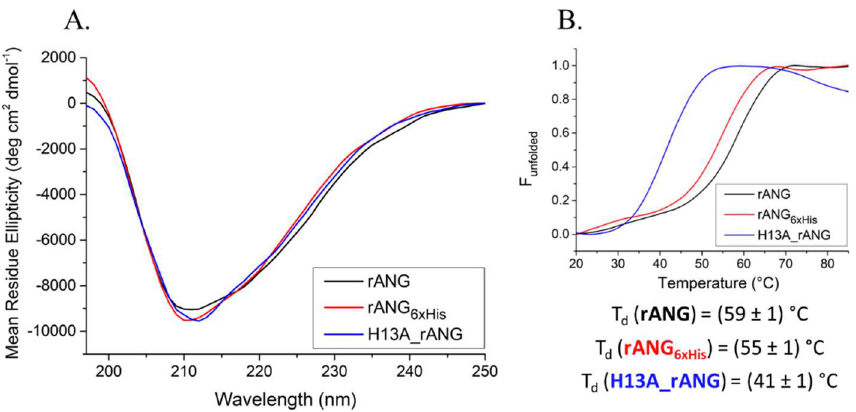
Figure 3. CD analysis of rANG and its variants. ( A ) CD spectra recorded at 20 °C in 20 mM of MES/NaOH pH 6.0 and 100 mM NaCl, using a protein concentration of 0.1 mg mL −1 ; ( B ) thermal denaturation profiles, as followed by monitoring changes in the molar ellipticity at 220 nm as a function of temperature. The denaturation temperature (T d ) for each protein is shown in panel B.